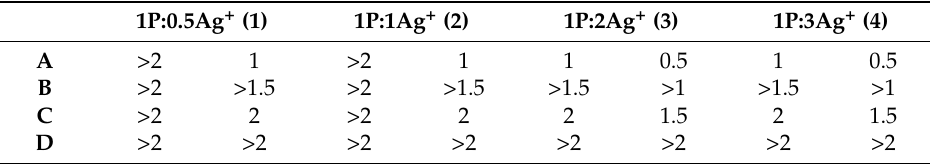
Table 8. MBC (left) and MIC (right) of the nanocomposites in mg/mL against S. aureus .